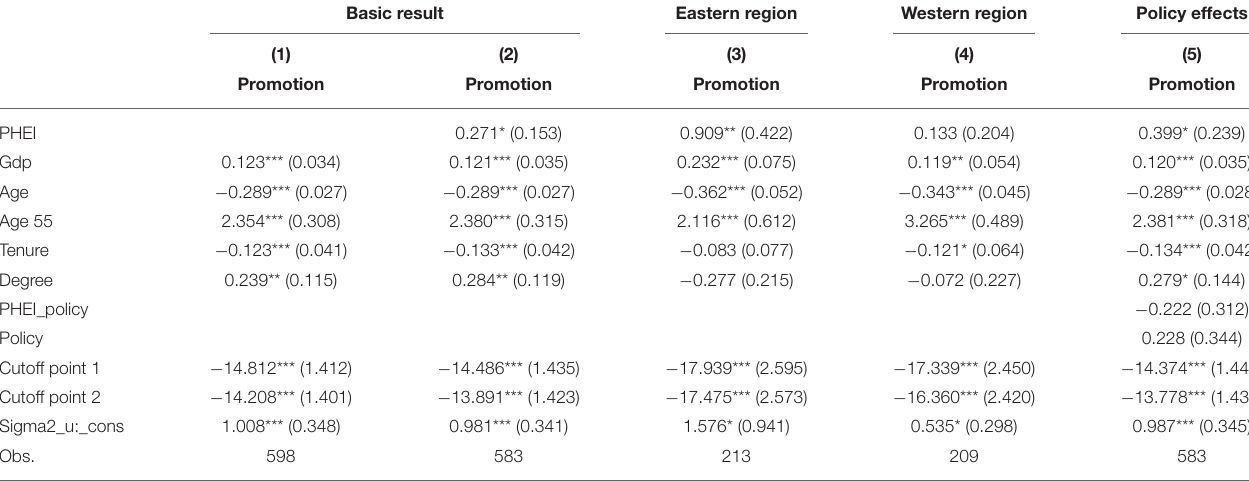
TABLE 4 | Regression results of the ordered Probit